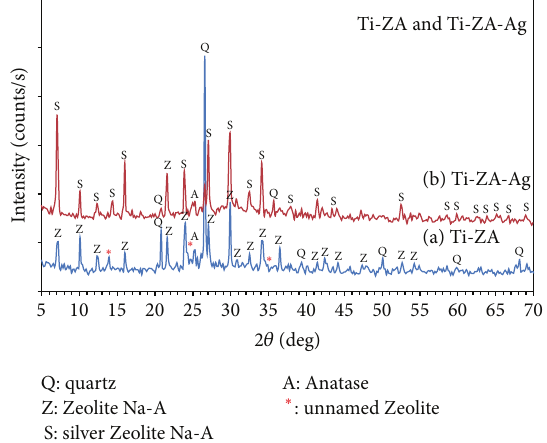
Figure 3: X-ray pattern for Ti-Zeolite (Ti-Z-A) and its silver- exchanged form (Ti-Z-Ag).